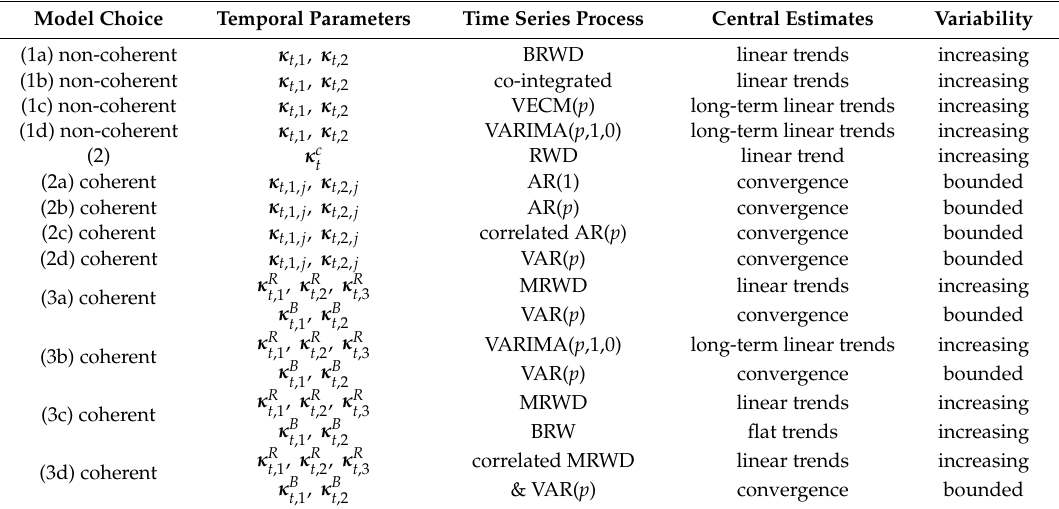
Table 2. Major characteristics of time series processes under di ff erent mortality projection models.